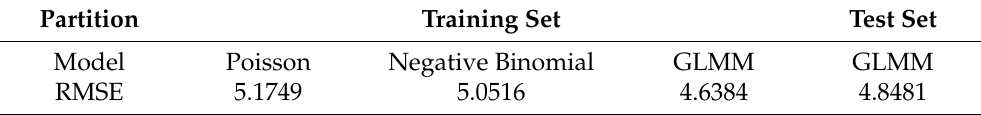
Table 7. Summary fit